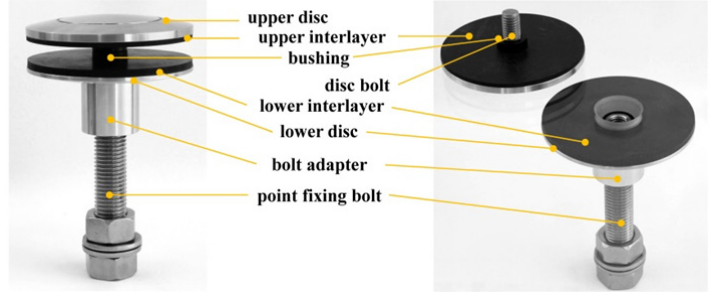
Fig. 1 Typical point fixing